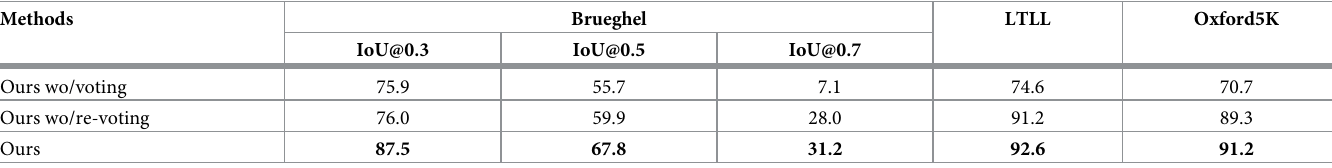
Table 4. Effect of the iterative voting.